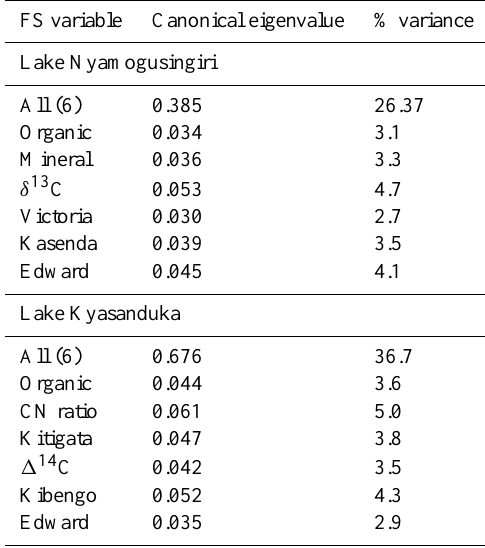
Table 2. Results of CCA of the forward-selected (FS) environmen- tal variables at Lake Nyamogusingiri and Lake Kyasanduka (last 1000 years) using the full data sets (all samples pre-AD 1975). The unique variance explained by each variable is also given. The p value for all variables is